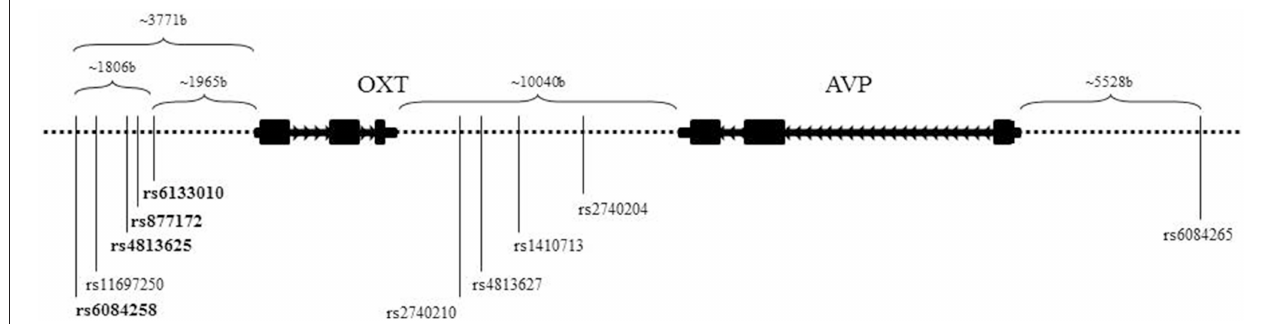
FIGURE 1 | Schematic of neurohormone genes, OXT and AVP . Located on chromosome 20, OXT and AVP are closely positioned and in opposite transcriptional orientations. The SNPs listed are the 10 genotyped SNPs utilized in this study. The bolded SNPs denote the SNPs used in the haplotype.